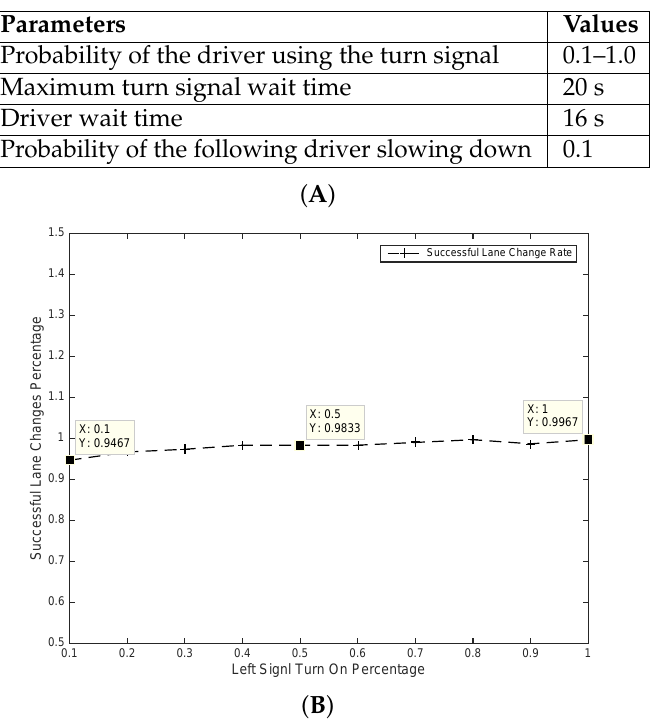
Figure 3. ( A ) the parameters for simulating the impact of the turn signal; ( B ) the rate of successful lane change function of the probability of the driver to use the turn